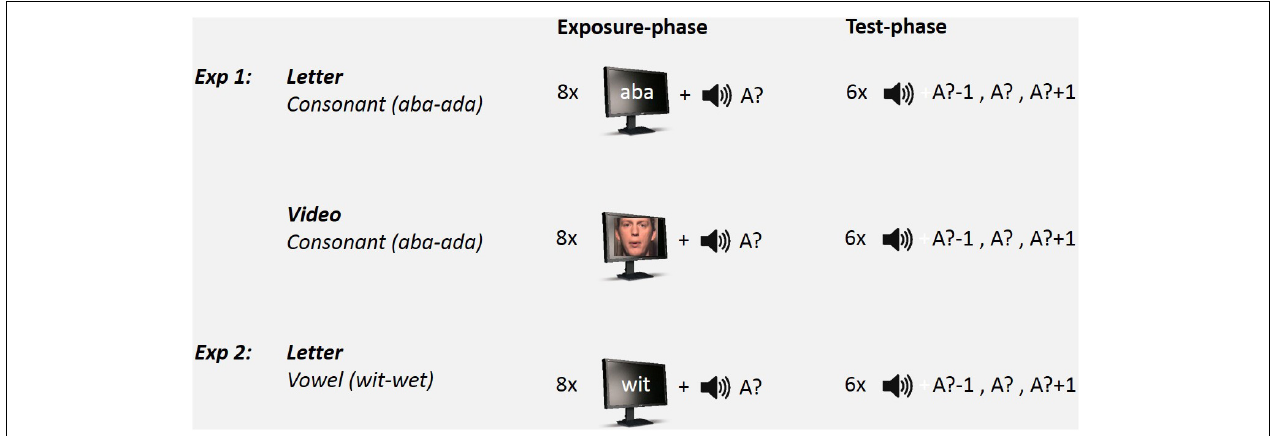
FIGURE 1 | Schematic set-up of the Exposure-Test paradigm (only exposure to ambiguous speech sounds is shown). In Experiment 1, participants were exposed to 8 auditory-visual exposure stimuli followed by 6 auditory-only test trials on an ‘aba’–‘ada’ continuum. Visual stimulus type during exposure consisted of either Text (Letter) or Lipread (Video) stimuli. In Experiment 2, participants were only exposed to Text stimuli and tested on a ‘wit’–‘wet’ continuum.